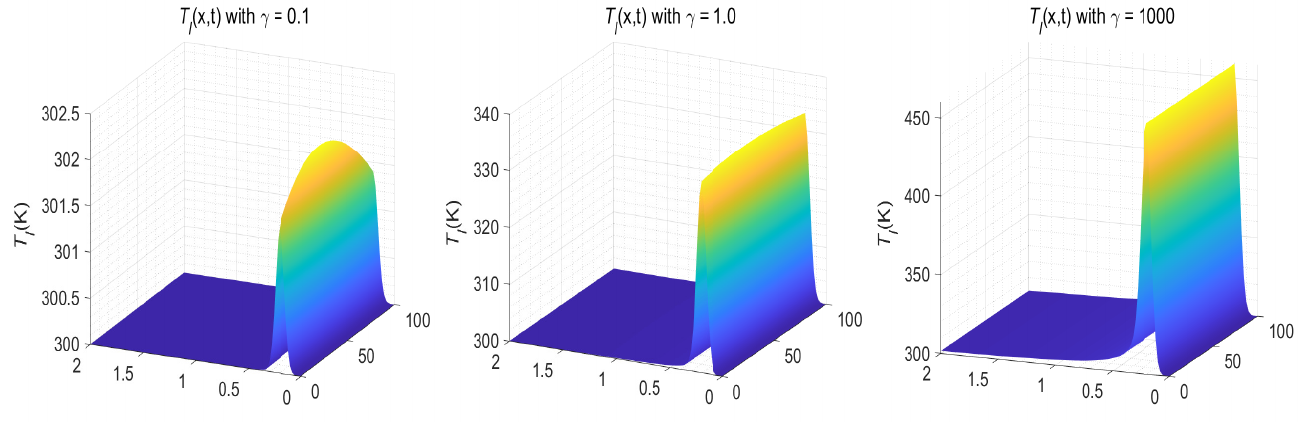
Figure 22. Temperature distributions of T l versus ( x , t ) with various γ when K n = 6.184658, ( α , β ) = ( 0.1,0.1 ) , N = 100, and M = 100 for Example